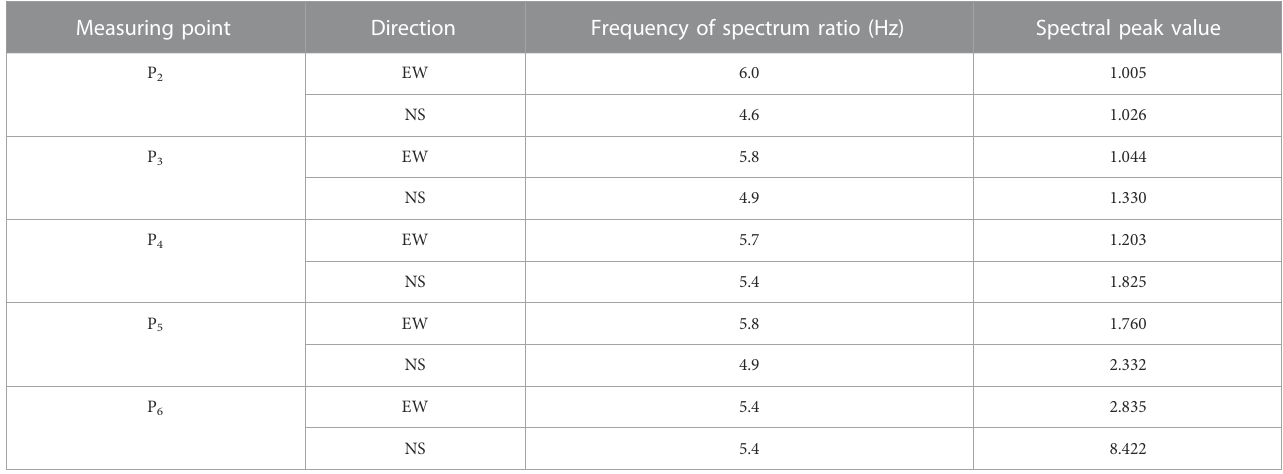
TABLE 1 Spectrum ratio of observation points on the